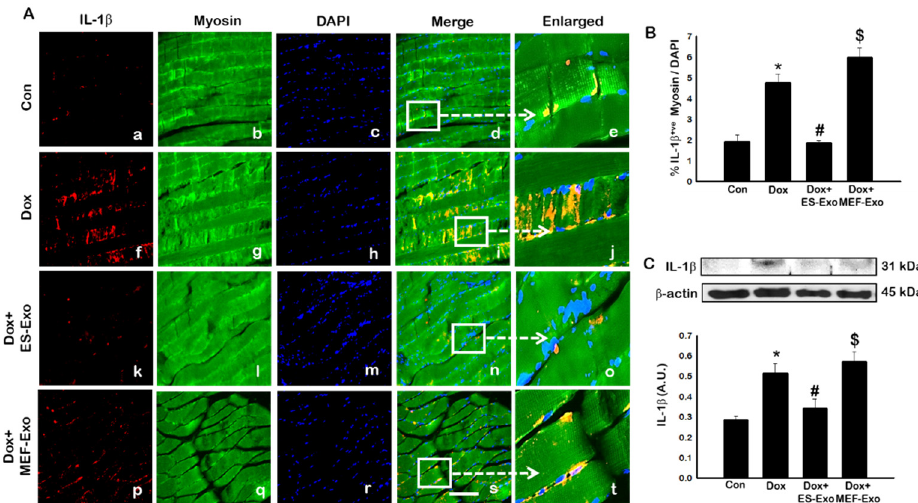
Figure 6. Treatment with ES-Exos reduces IL-1 β secretion induced by Dox. ( A ) Representative photomicrographs of soleus muscle sections stained with myosin and pyroptotic marker, IL-1 β . Each box shows IL-1 β + cells in red ( a , f , k , p ), myocytes in green ( b , g , l , q ), DAPI in blue ( c , h , m , r ), merged images ( d , i , n , s ), and enlarged areas of merged images ( e , j , o , t ). ( B ) Histograms from quantitative analysis of IL-1 β + cells over total DAPI. ( C ) Representative blot and densitometric analysis of IL-1 β . Error bars = mean ± S.E.M. * p < 0.05 vs. control, # p < 0.05 vs. Dox, $ p = non-significant vs. Dox, one-way ANOVA followed by Tukey test; western blot quantities are represented as A.U. Scale bar = 100 µm, n = 14–16, male and female ( B ) and n = 6–8, male and female ( C ). Images taken at 40 × magnification.